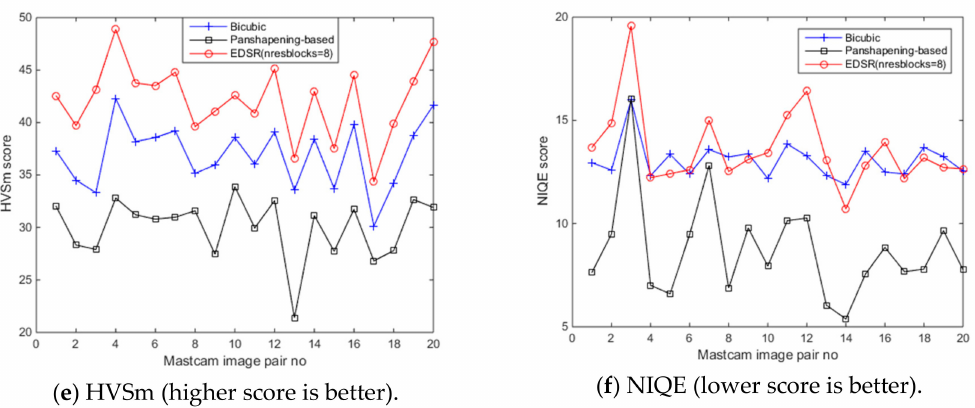
Figure 18. Enhancement comparisons with six image quality measures for the 20 Mastcam image pairs.